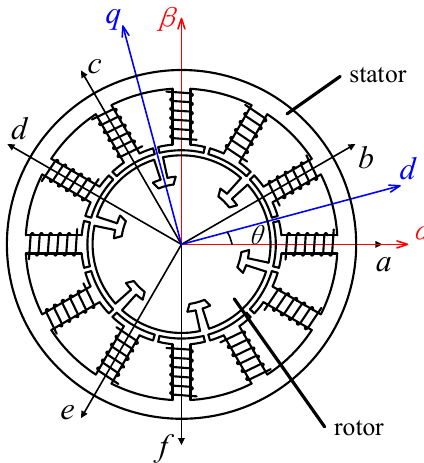
Figure 1. Structure of dual three-phase PMSM. The dual three-phase PMSM is actually a complete set of six-phase permanent magnet synchronous motor (6P-PMSM) system. More advantages of 6P-PMSM can be achieved by using fault-tolerant control and optimizing the connection of neutral